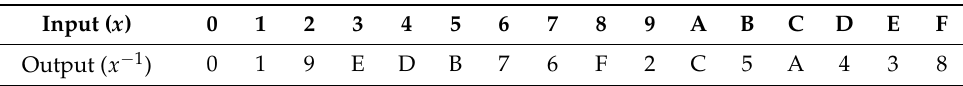
Table 4. Inversion table values in